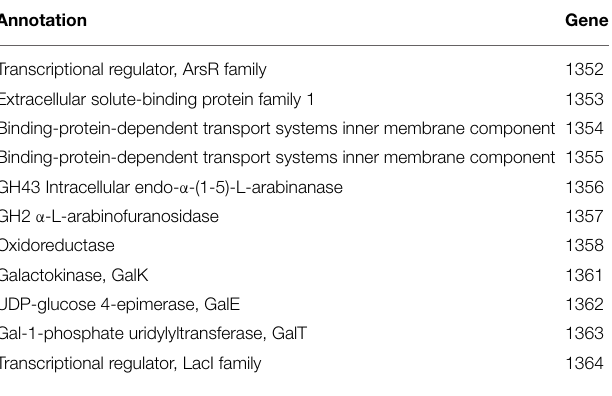
TABLE 7 | 56T3 Arabinose and arabinan metabolic cluster.